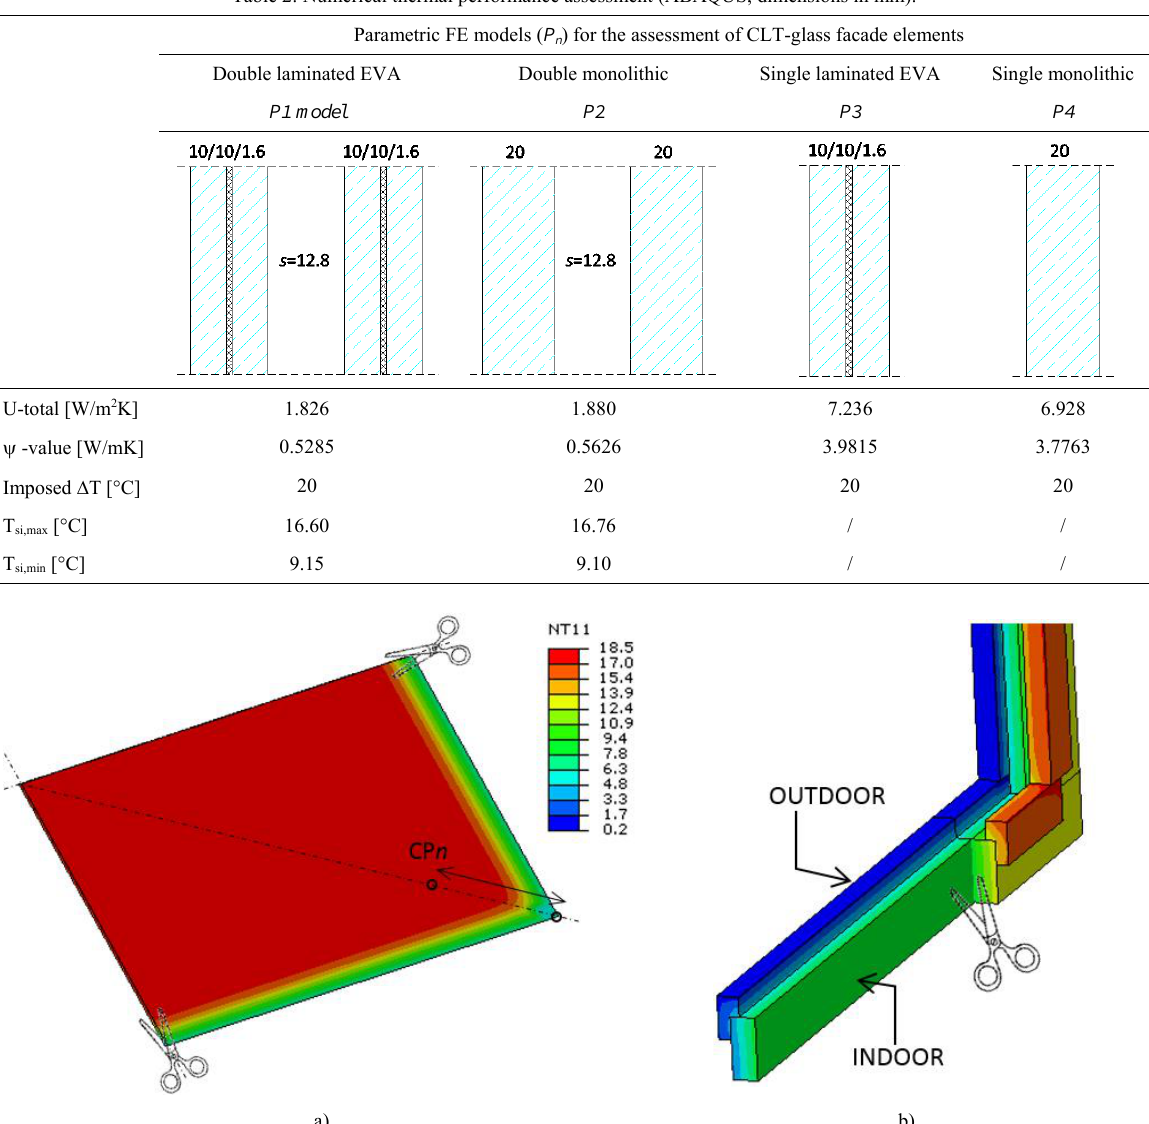
Table 2: Numerical thermal performance assessment (ABAQUS, dimensions in mm).